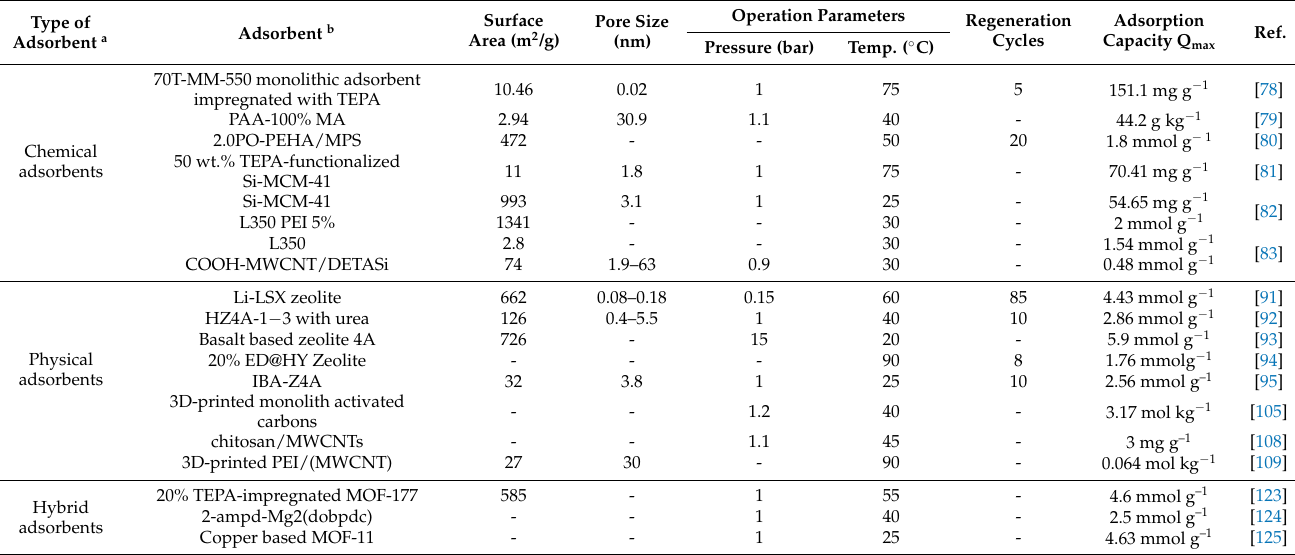
Table 3. Adsorbents for carbon dioxide